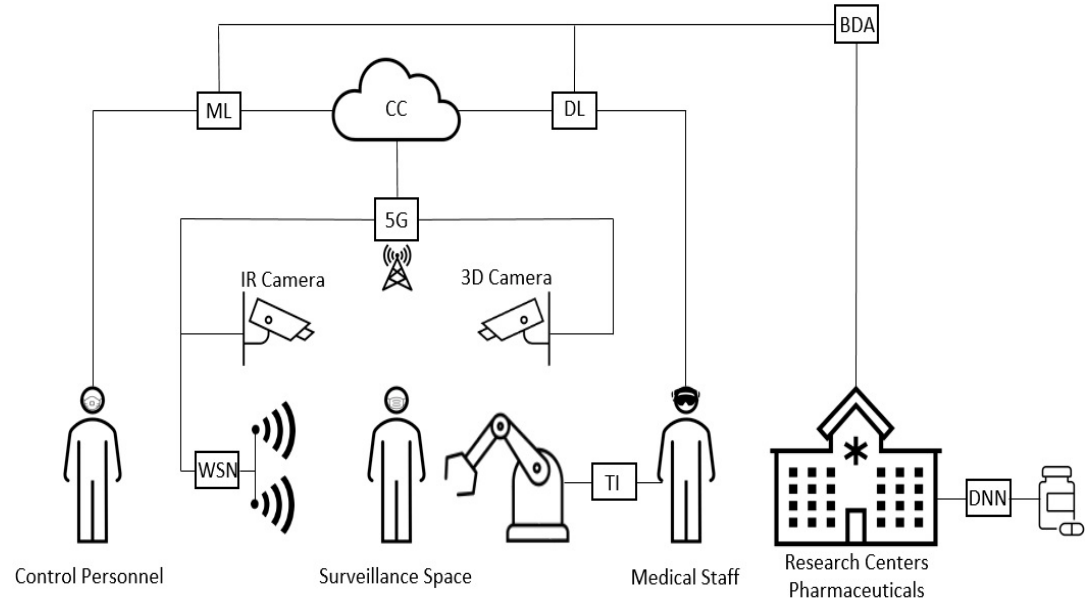
Figure 9. Proposed smart healthcare system architecture.